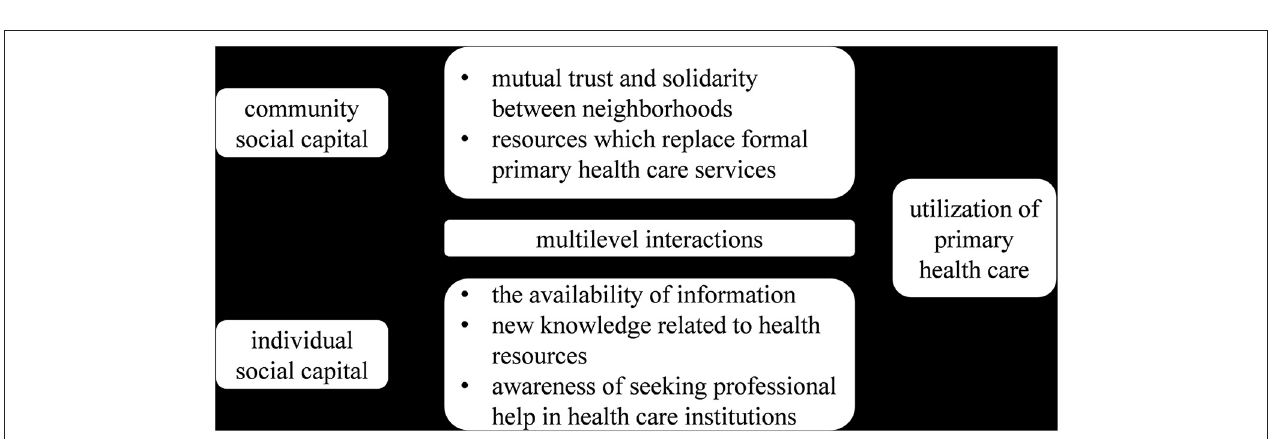
FIGURE 1 | Conceptual model of association of community and individual social capital with PHC